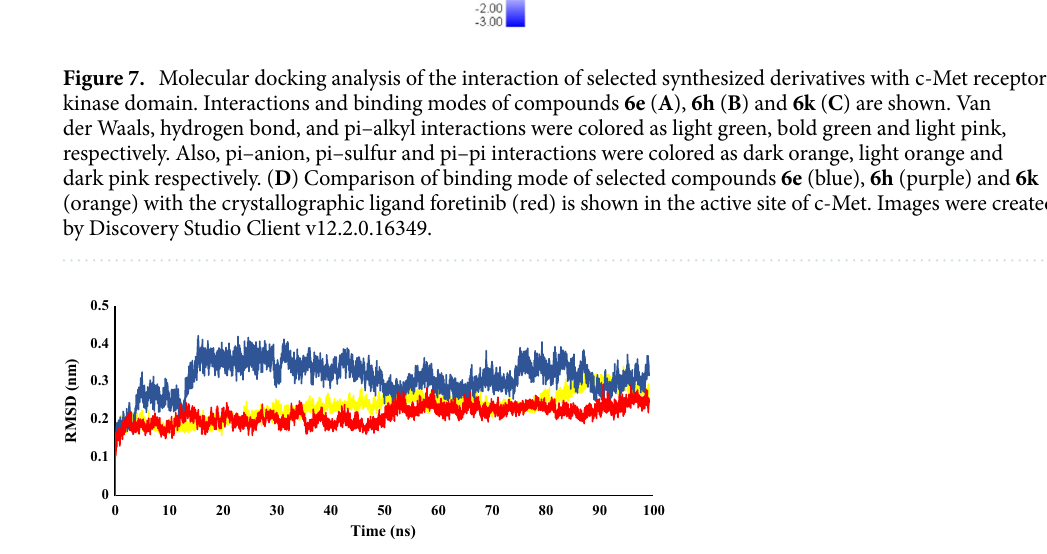
Figure 8. RMSD analysis of MD simulation of the interaction of selected synthesized derivatives with c-Met receptor. To resolve the MD equilibrium time range, the RMSD plot of the protein backbone atoms versus time for the interaction of the active derivatives 6d (yellow), 6e (blue), and 6f (red) with c-Met (PID: 3LQ8) was investigated. The equilibrium time ranges of 44, 15 and 55 ns were observed for complexes of 6d , 6e and 6f with c-Met, respectively. The RMSD figure was drawn by Microsoft Excel